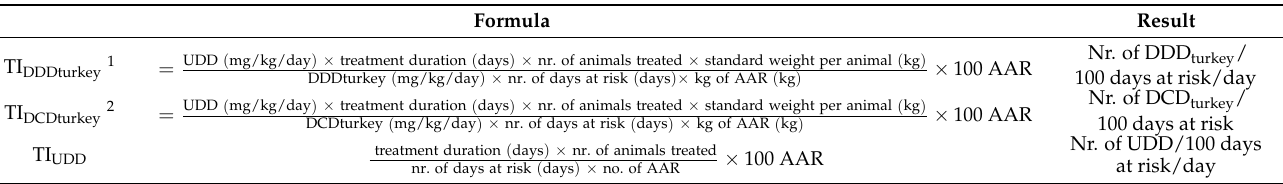
Table 4. Formulas to quantify antimicrobial usage using treatment incidence (TI). Formula